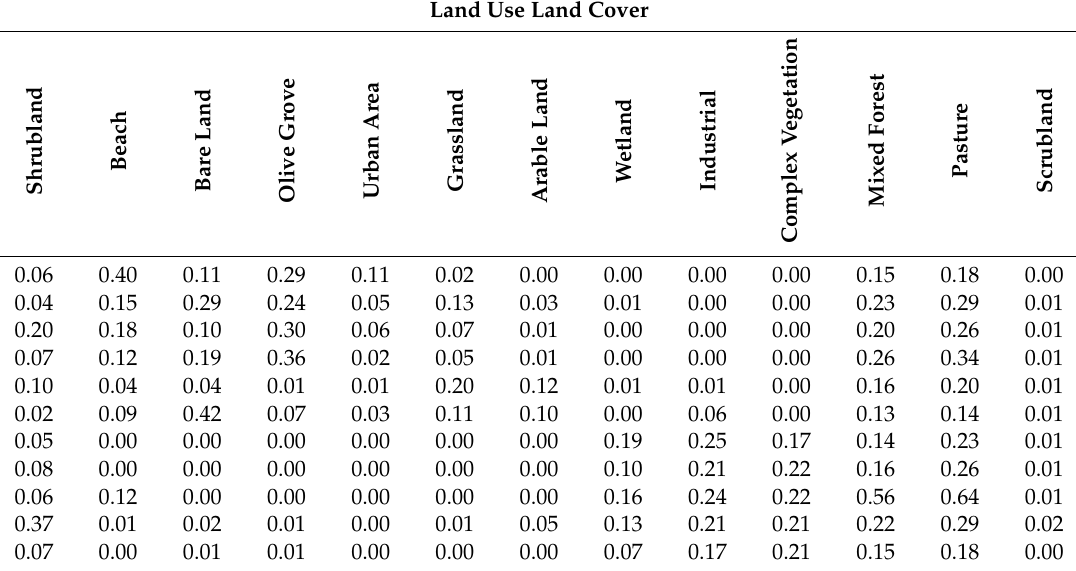
Table 3. Cross-tabulation of Land Cover Land Use classes. Land Use Land Cover